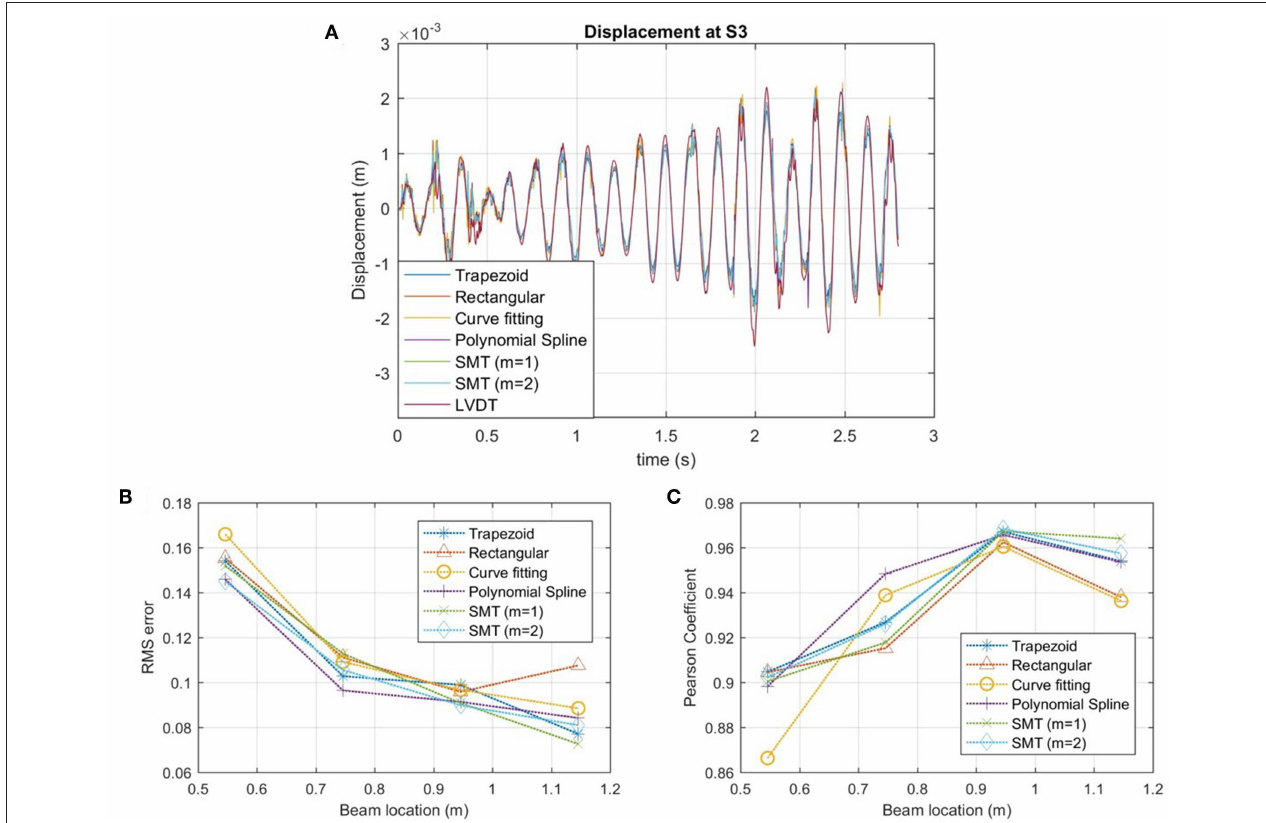
FIGURE 9 | Random impact dynamic test (A) displacement response at mid-span of simply supported beam, (B) RMS error, and (C) Pearson coefficient.